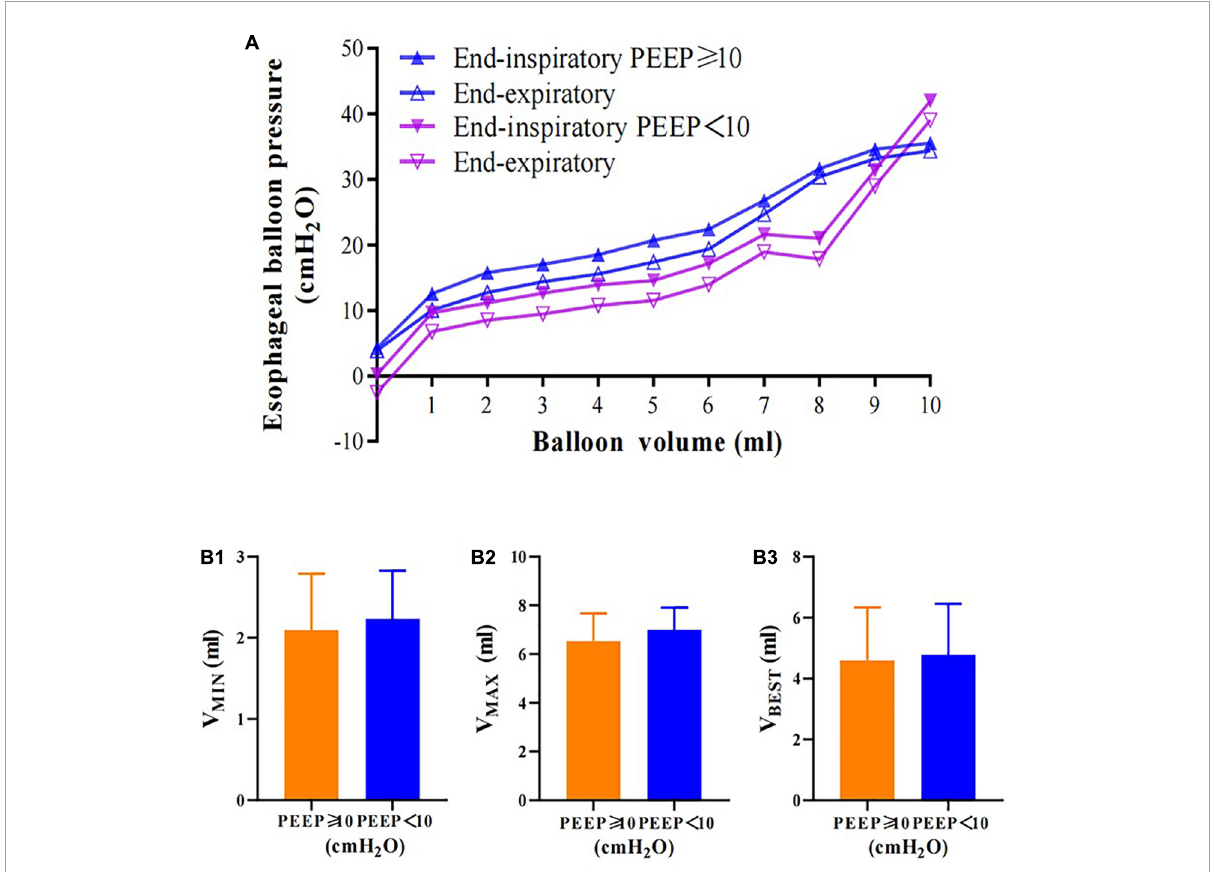
FIGURE5 Esophageal balloon pressure-volume curves of different PEEP groups. (A) Relationship between balloon filling volume and values of Pes in the PEEP ≥ 10 cm H 2 O (Pes EI , solid blue triangle; Pes EE , hollow blue triangle) and PEEP < 10 cm H 2 O (Pes EI , solid purple triangle; Pes EE , hollow purple triangle). Patients in the PEEP < 10 cm H 2 O group had lower Pes than those the PEEP ≥ 10 cm H 2 O group. (B) Patients in the PEEP < 10 cm H 2 O group had higher V MIN , V MAX , and V BEST than those in the PEEP ≥ 10 cm H 2 O group. Pes: esophageal pressure. No significant difference was observed.